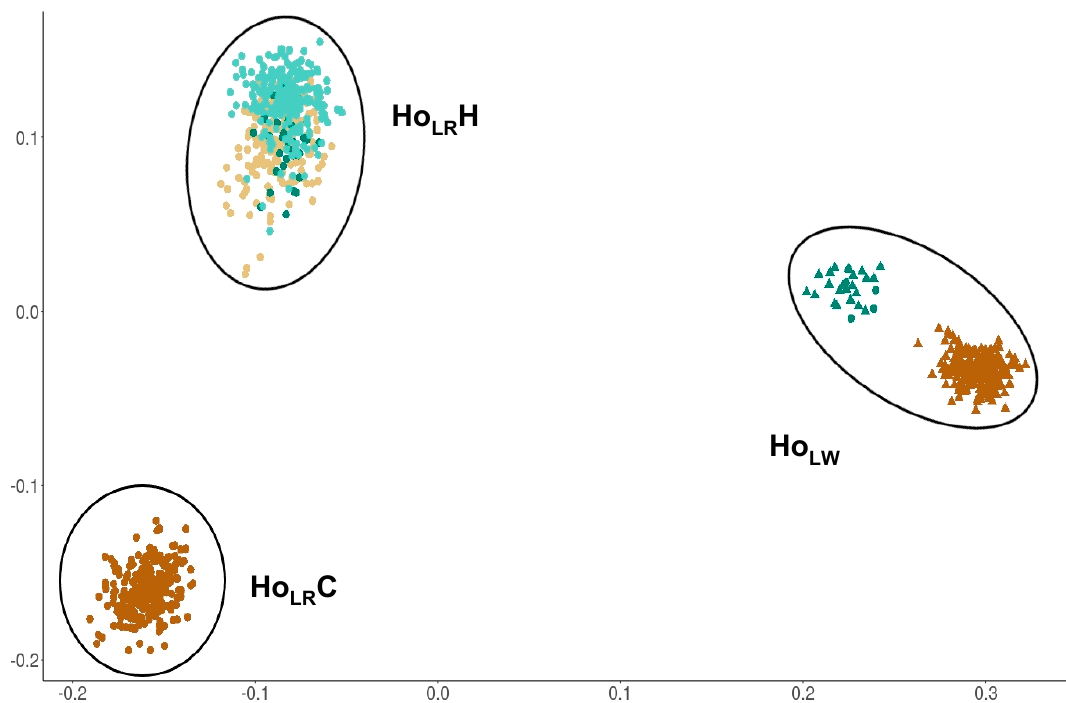
Figure 1. Distribution of animals from hormone dataset in clusters based on genetic relationship matrix, Ho LR C n = 254, Ho LW n = 272, Ho LR H n = 447. Colors are representing the different organizations. Filled-in circles are representing Landrace animals; filled-in triangles are representing Large White animals.